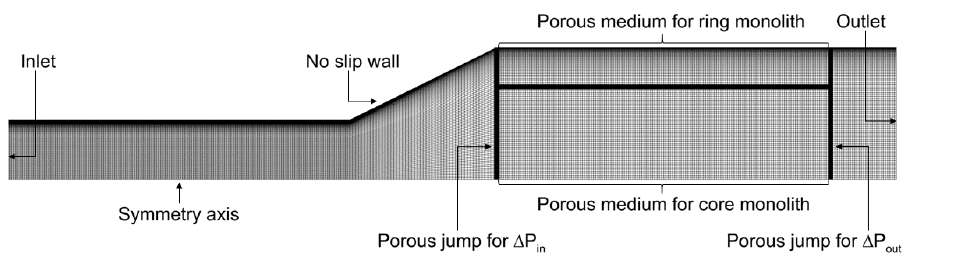
Figure 1. Schematic of the computational